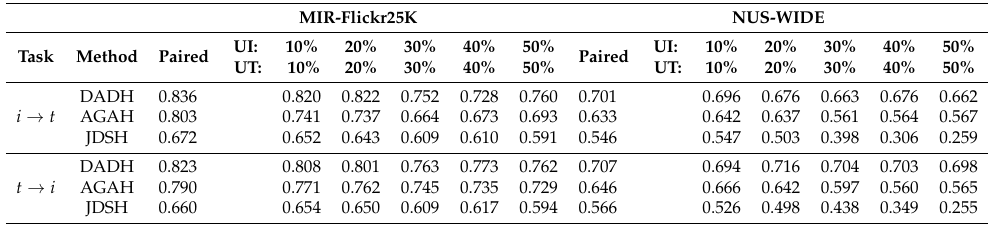
Table 5. Results (mAP) on MIR-Flickr25K and NUS-WIDE with unpaired images and text, i.e., images with no corresponding text and vice versa. Column ‘Paired’ shows results when training with a fully paired training set. Subsequent columns show results with increasing amounts of unpaired images and text in the training set, for example, ‘10% 10%’ refers to 10% of the training set being unpaired images (UI) and another 10% being unpaired text (UT) for a total of 20% of the dataset being unpaired